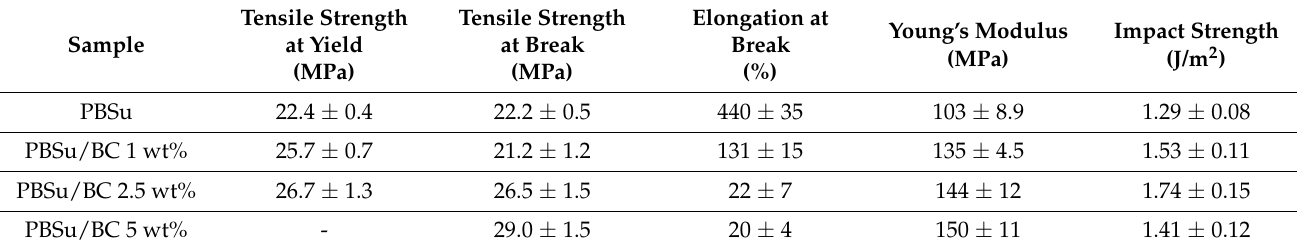
Table 4. Mechanical properties of PBSu/BC biocomposites.